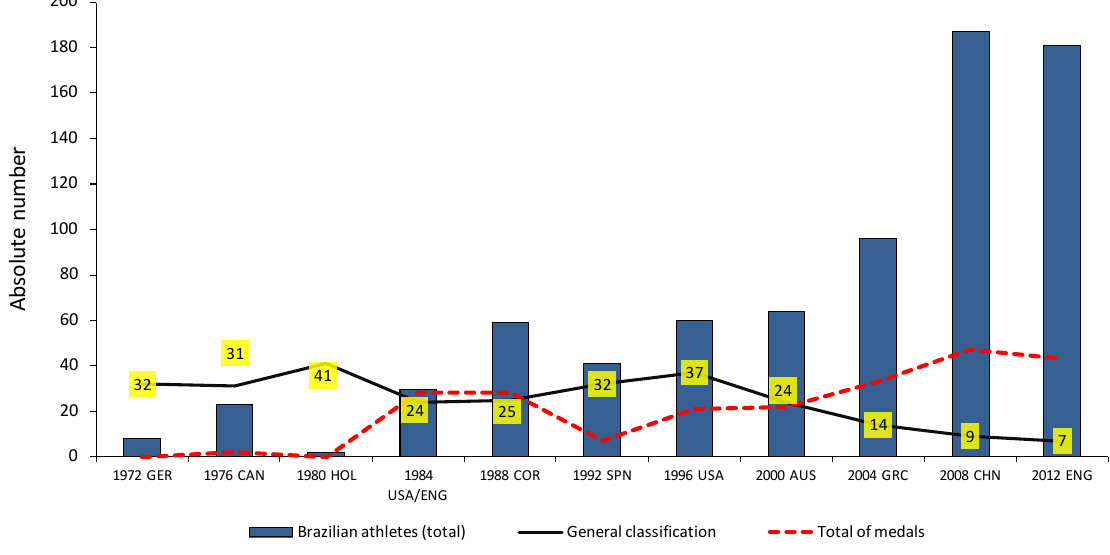
Figure 4. Absolute number of participant Brazilian athletes, earned medals, and general classification position in the Paralympic Games, from 1972 until 2012 (source: IPC,